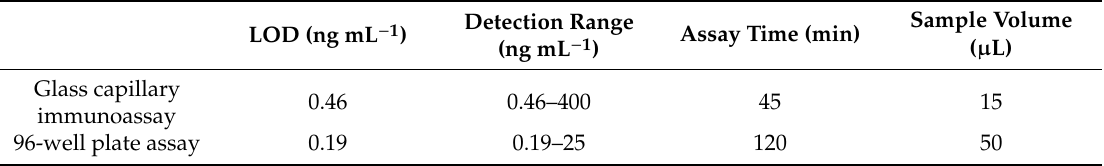
Table 1. Comparison of LOD, detection range, assay time, and sample volume between the anti-p53 autoantibody assays of glass capillary platform and typical protocol of 96-well plate.